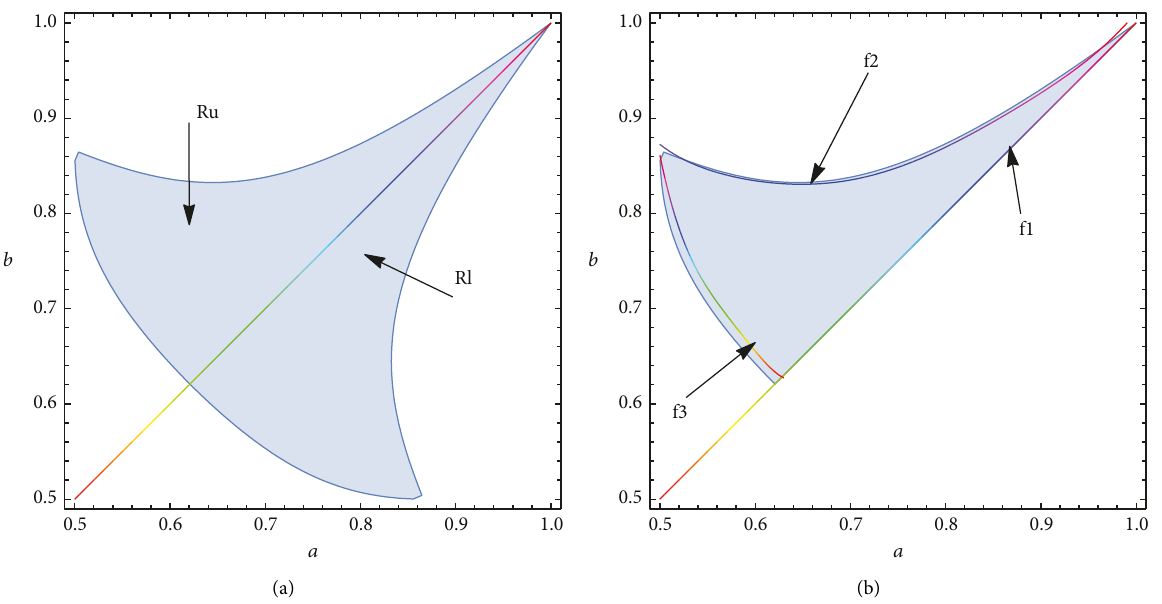
Figure 4: (a) Central configuration region (shaded): (b) upper central configuration is surrounded by three interpolating curves (hue